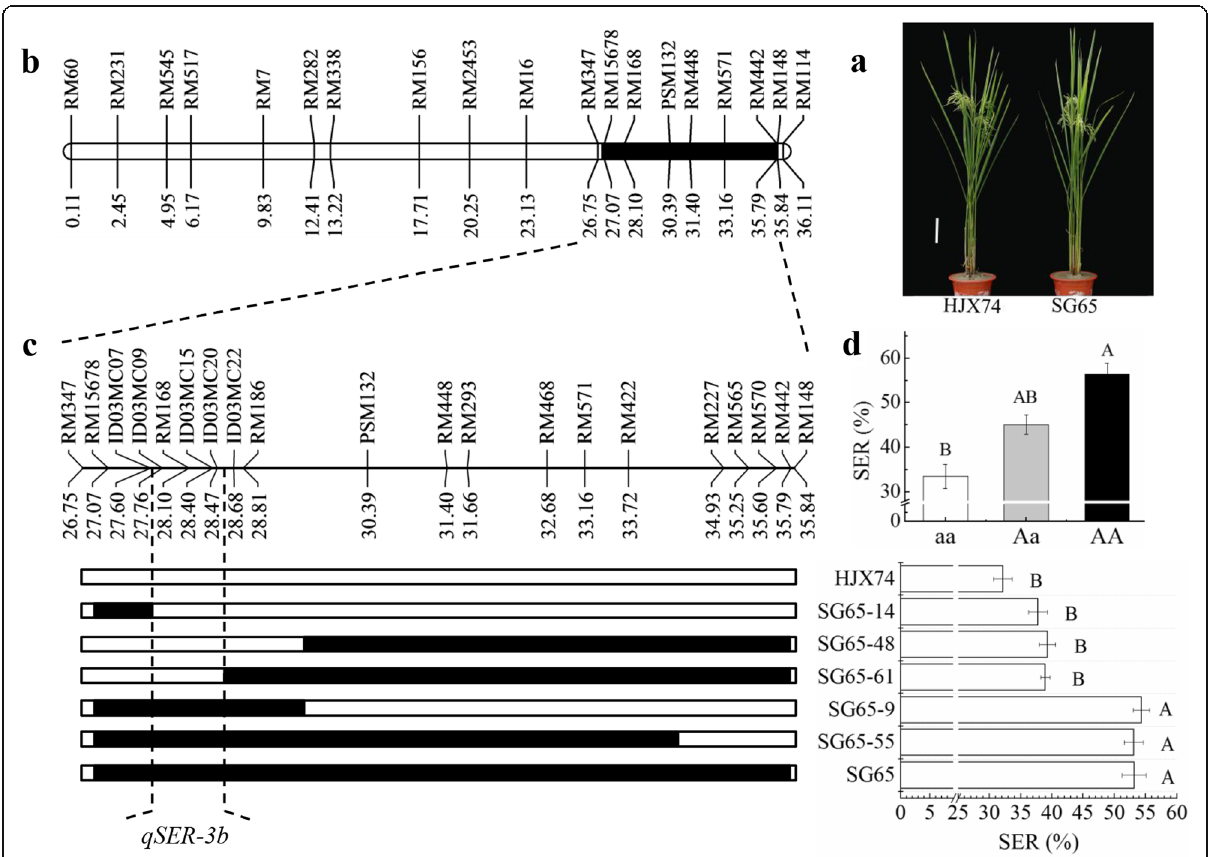
Fig. 3 Secondary substituted mapping of qSER-3b . a Plant type of HJX74 and SG65. Scale bar, 15 cm. b The substituted segment of SG65 on chromosome 3. c Substitution mapping of qSER-3b , showing position of substituted segments and stigma exsertion rate (SER) of the SSSLs with HJX74 as the control. d SER effects of three qSER-3b genotypes in a F 2 population. White and black blocks on chromosomes represent genotypes of HJX74 and donor, respectively. aa: Homozygous genotype of HJX74. Aa: Heterozygous genotype of SG65/HJX74. AA: homozygous genotype of SG65. Threshold, α = 0.001, one-way ANOVA, Duncan,